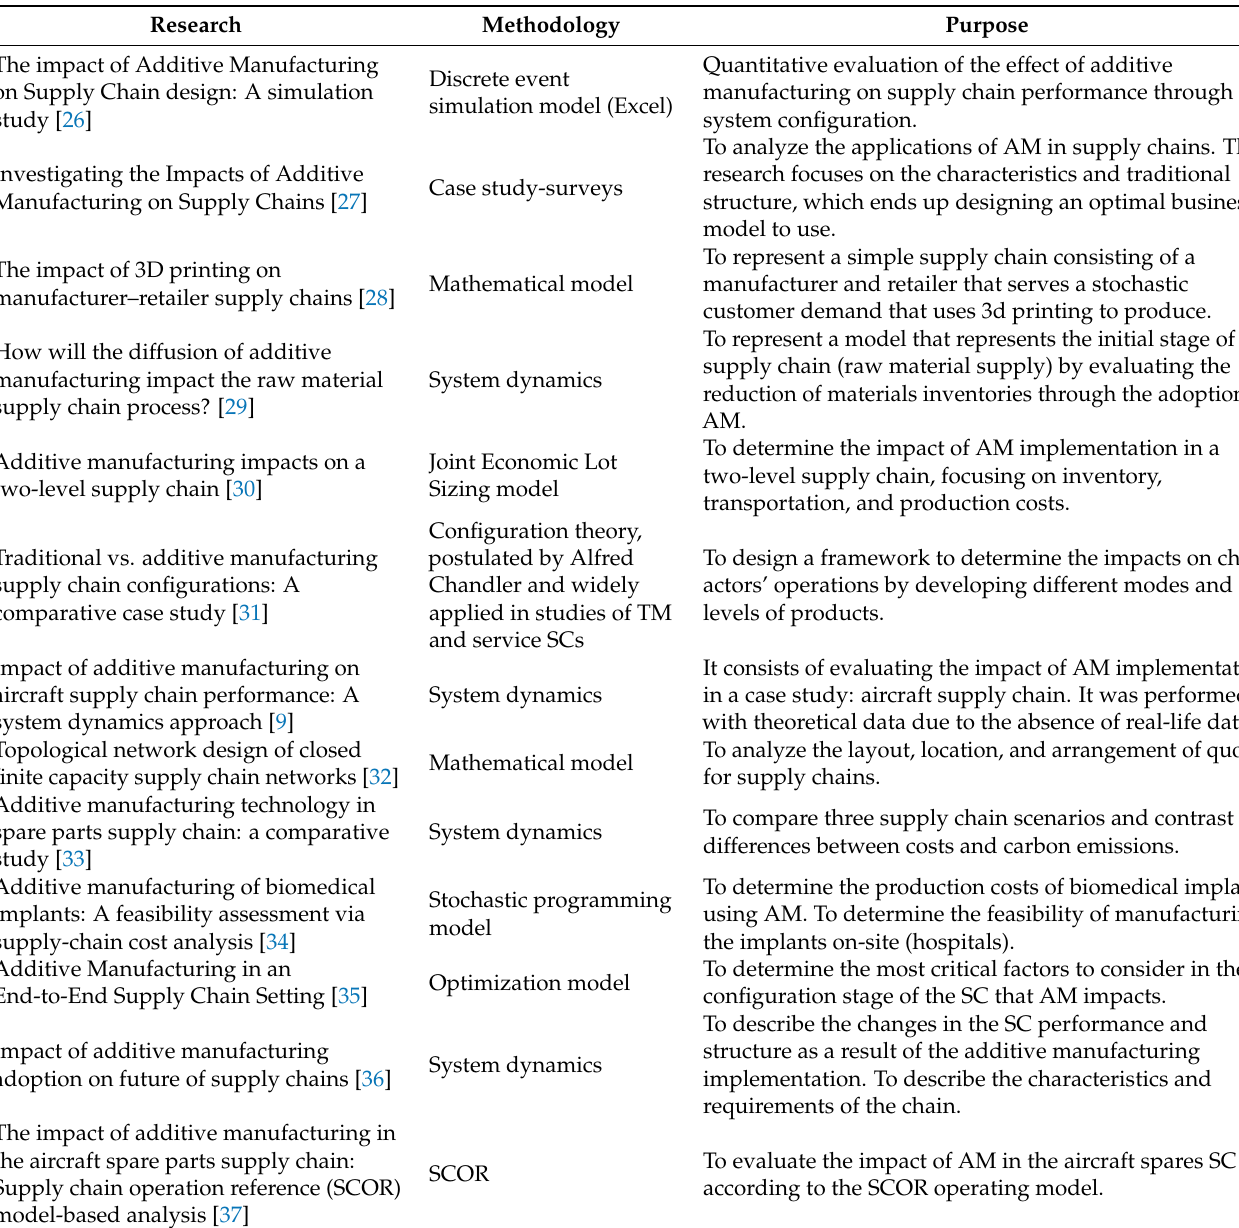
Table 2. Studies of Impacto f the additive manufacturing in the supply